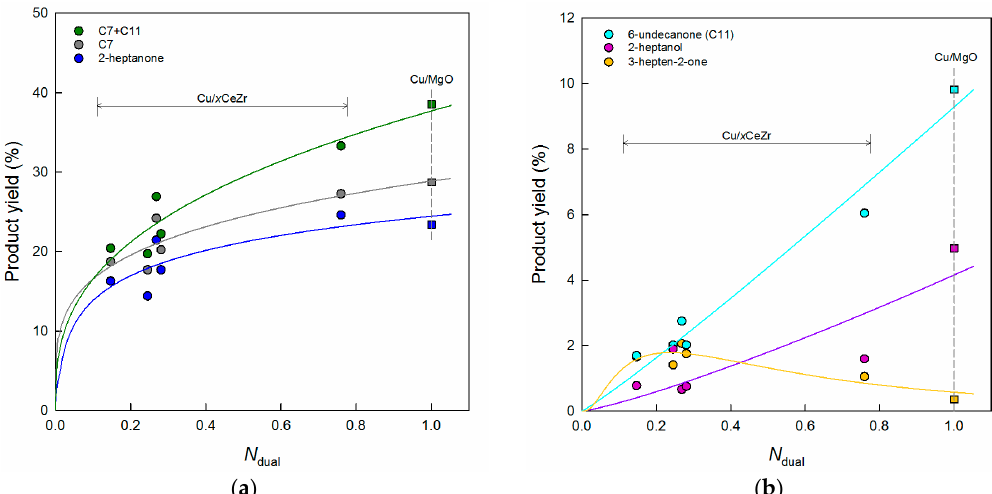
Figure 7. ( a ) Acetone conversion and ( b ) product selectivities plotted against the normalized value ( N dual ) of Cu/ x CeZr (circles) and Cu/MgO (squares) catalysts. C7 includes 3-hepten-2-one, 2-heptanone, and 2-heptanol.